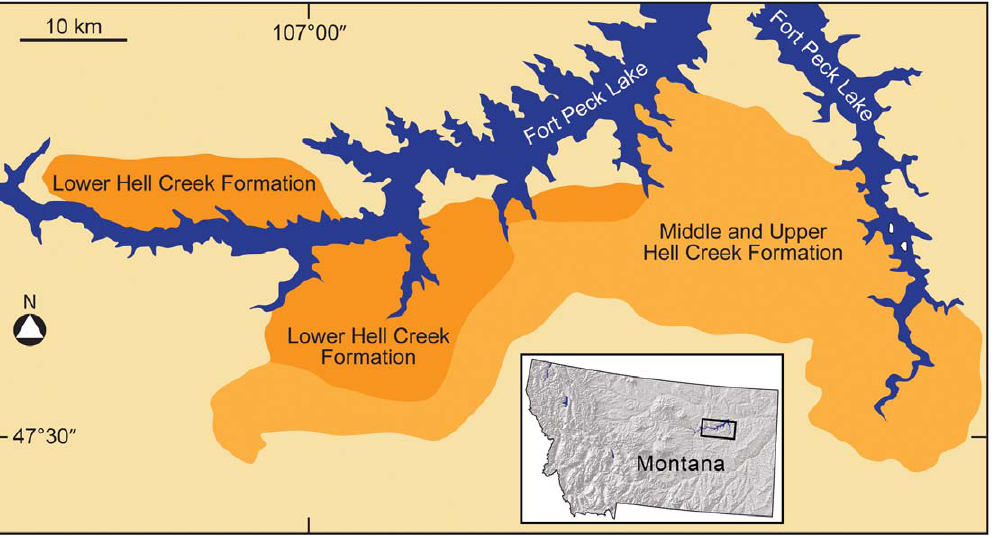
Figure 1. Index map of the Upper Cretaceous Hell Creek Formation along Ft. Peck Lake in northeastern Montana, USA. Contiguous outcrops are traceable over an area of about 1000 square km adjacent to Fort Peck Lake shown in blue. Dark orange represents the lower Hell Creek Formation and light orange represents the middle and upper Hell Creek Formation. The enlarged view of the study area is indicated by the rectangle in the northeast quarter of the map of Montana.